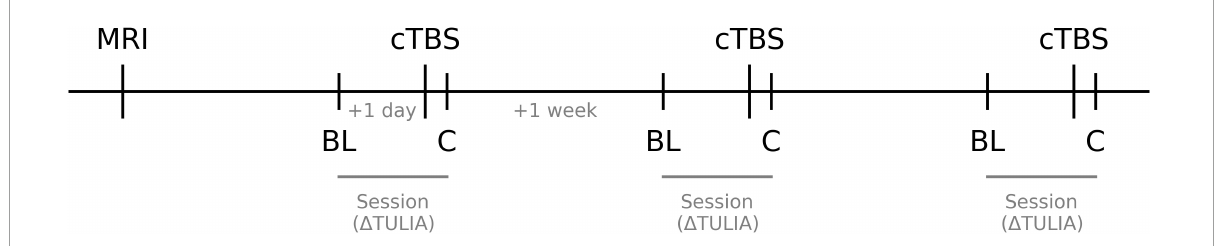
FIGURE1 Schematic representation of the experimental protocol. MRI, acquisition of fractional anisotropy with magnetic resonance imaging. BL, Session-related baseline behavioral assessment. C, Session-related control behavioral assessment. cTBS, sham or continuous theta burst stimulation over IPL-R or IFG-R; the order of the stimulation sessions was pseudorandomized with the sequence xyz, xzy, yxz, yzx, zxy or zyx, where x, sham, y, cTBS over right inferior parietal lobe, z, cTBS over right inferior frontal